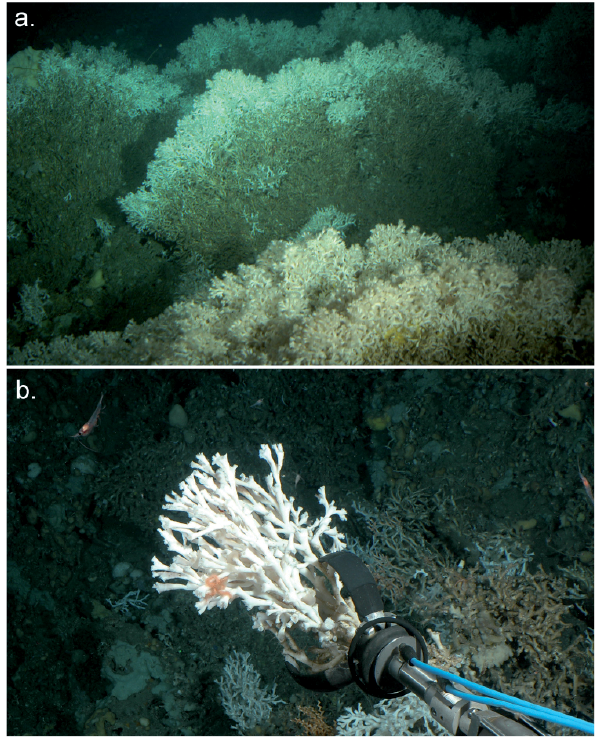
Fig. 1. Submersible dives on Røst reef in June 2007, (a) im- age taken looking down a steep wall with large L. pertusa but- tresses extending 3–4m out from the substratum; dead skele- tons are encrusted in brown metal oxides, living parts are white (67 ◦ 30 0 30 00 N 9 ◦ 25 0 30 00 E, 340m depth). (b) Coral collection from reef crest formed by orange and white M. oculata and L. pertusa colonies. Krill and copepods were abundant during sample collec- tion (67 ◦ 30 0 20 00 N 9 ◦ 24 0 45 00 E, 300m